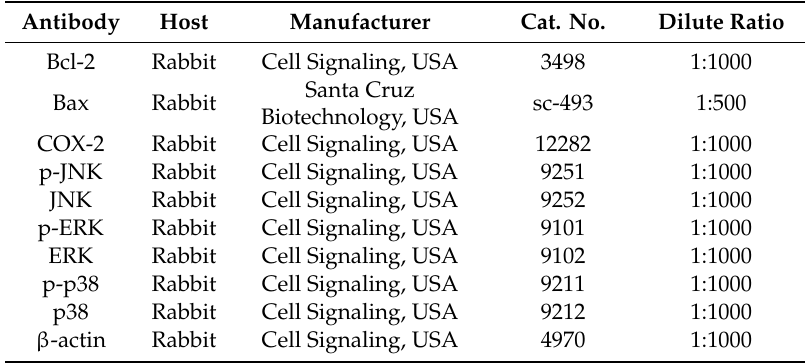
Table 1. Primary antibodies